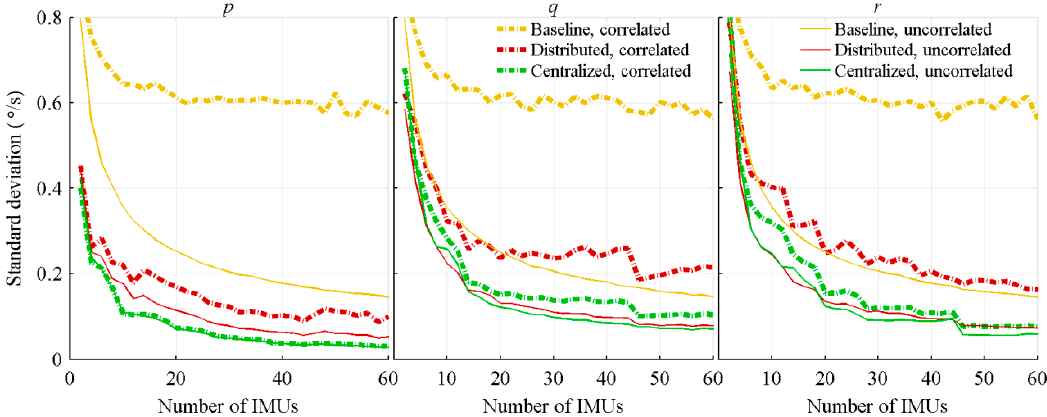
Figure 7. Standard deviation of the attitude rate estimation errors, with correlated and uncorrelated sensors bias, and function of the number of IMUs.